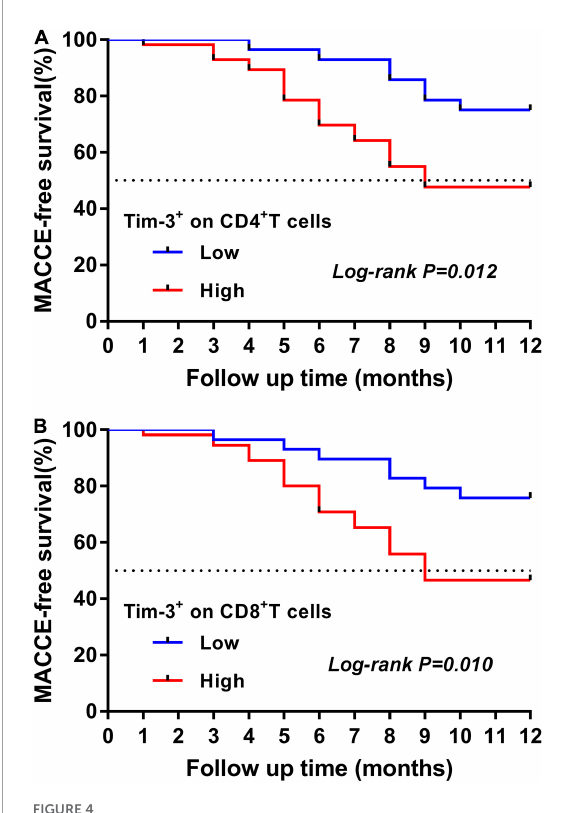
FIGURE4 Kaplan-Meier curve for the 12-month MACCE-free survival in patients with ADHF. (A) Time-to-event curves for the highest quartile (Q3–Q4) of Tim-3 expression on CD4 + T cells vs. the lowest quartiles (Q1–Q2) measured in ADHF patients according to the primary endpoints. The log rank test was used to compare the survival curves. (B) Time-to-event curves for the highest quartile (Q3–Q4) of Tim-3 expression on CD8 + T cells vs. the lowest quartiles (Q1–Q2) measured in ADHF patients according to the primary endpoints. The log rank test was used to compare the survival